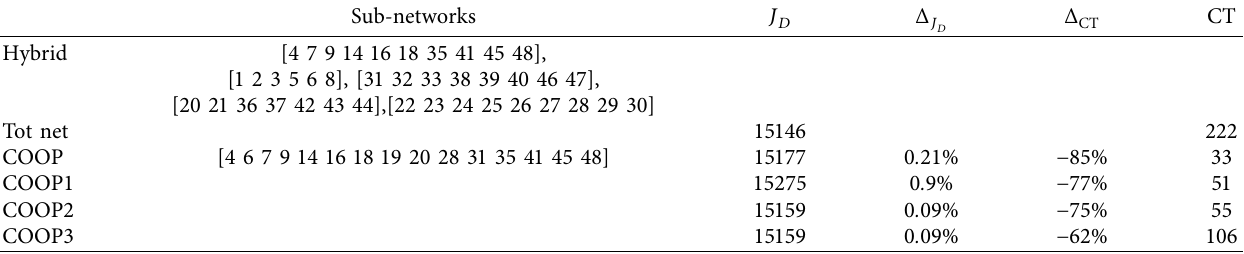
Figure 9: Trade-off efficiency-efficacy. Table 5: Decentralized vs centralized with Hybrid decomposition based on Newman clustering.